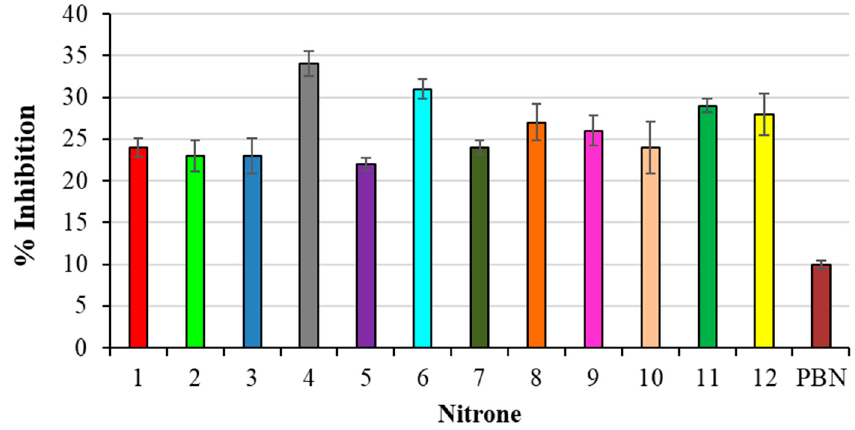
Figure 2. % Inhibition of TBARS formation in AAPH-induced liposomes peroxidation. Results are expressed as mean ± SD ( n = 5). All nitrones derivatives are significant against PBN nitrone.